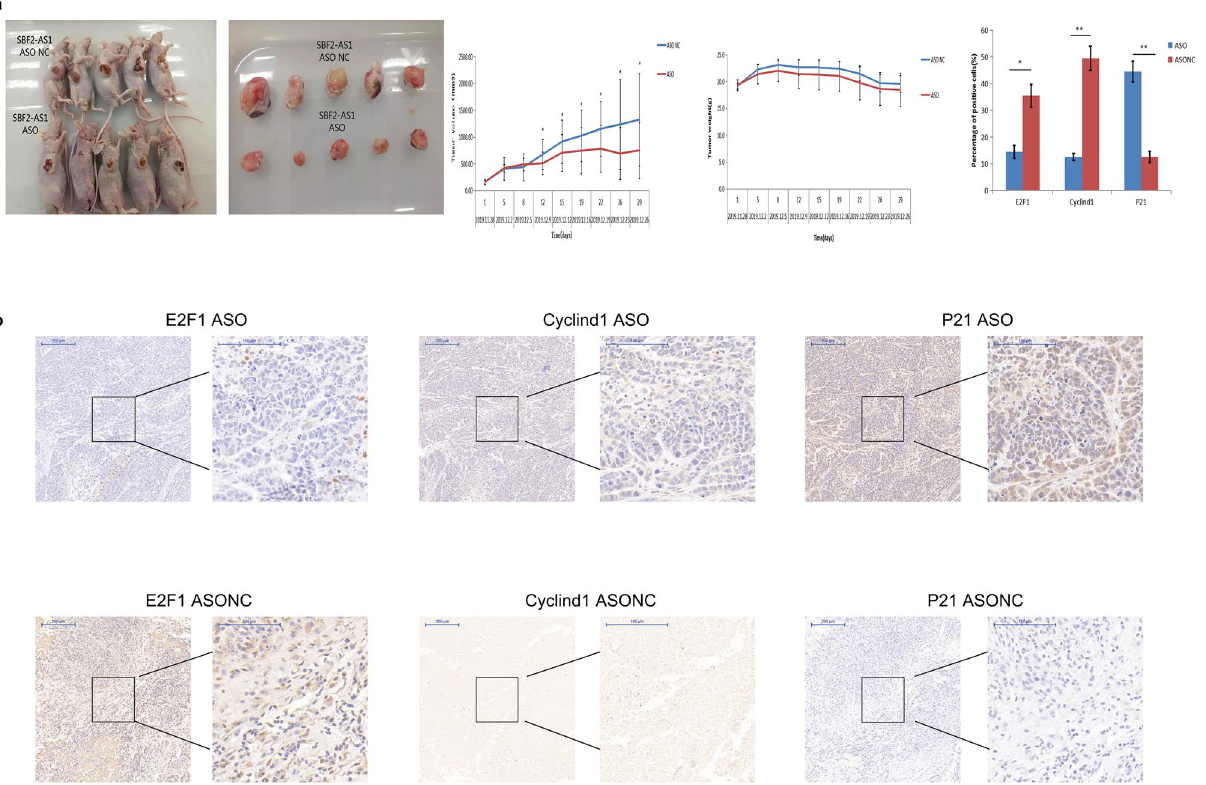
Figure 6. SBF2-AS1ASO could inhibit the growth of oesophageal squamous cell carcinoma in vivo. ( a ) Nude mouse xenograft model. Changes in mouse bodyweight and tumour volume in the nude mouse xenograft model and photographs of tumour xenografts are shown. ( b ) IHC staining of xenograft tumour tissues from mice in the SBF2-AS1 ASO group and SBF2-AS1 ASONC group is shown. Data are shown as the mean ± SEM. *P < 0.05, N.S. not statistically